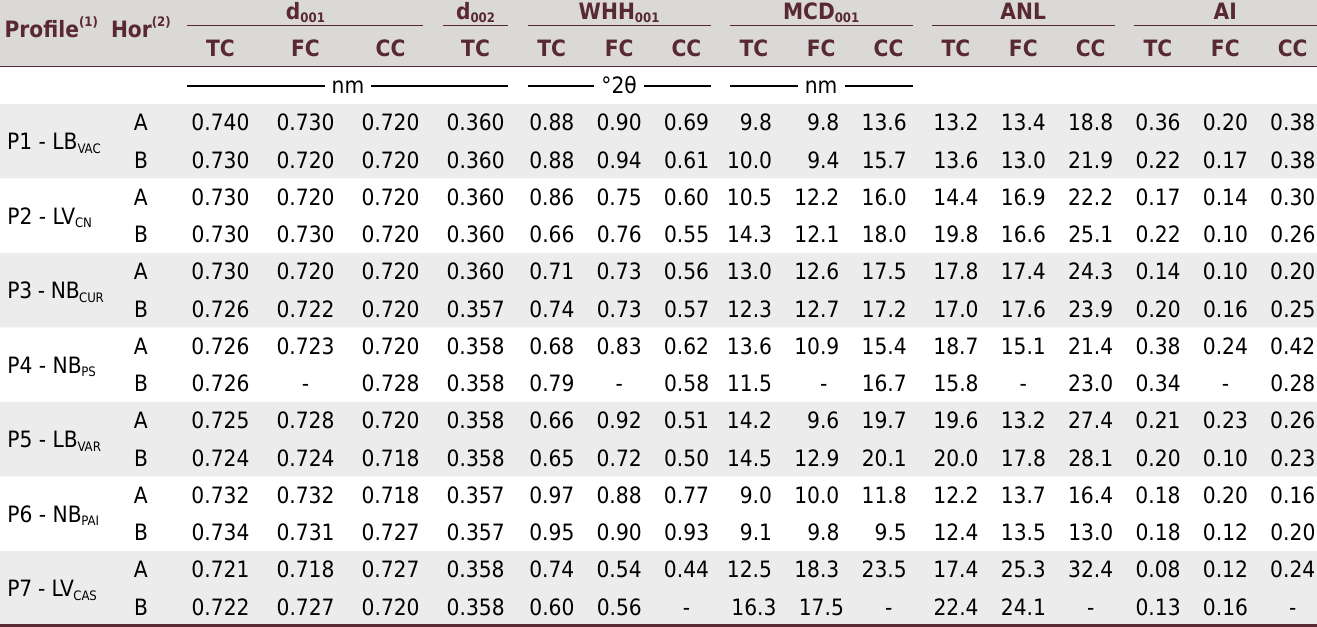
Table 3. Amounts referring to crystallographic parameters (WHH 001 - Width at Half Height in 001 plan; MCD 001 - Mean Crystal Dimension in the 001 plan, ANL - Average Number of Layers, and AI - Asymmetry Index) of “kaolinites” in the samples of the total clay (TC), fine clay (FC) and coarse clay (CC) samples in the A and B horizons of the profiles studied Profile (1) Hor